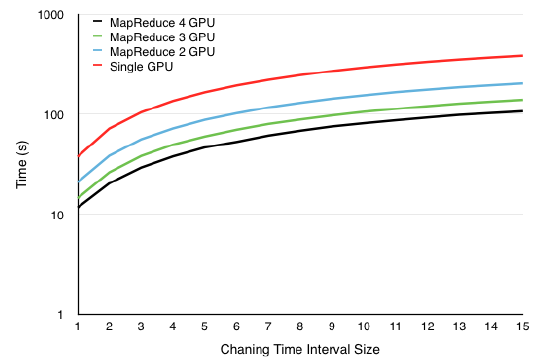
Figure 5. ST-Region GPU MapReduce timing with varying win- dow dimension (time interval T = 10 )